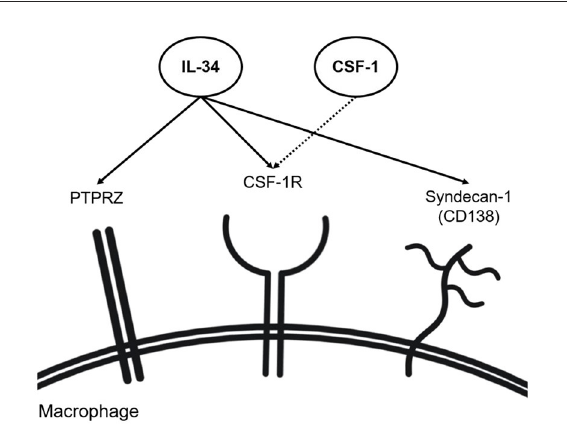
FIGURE1 IL-34 receptors (including co-receptors). IL-34 has shown the capability of binding to CSF-1R alongside CSF-1 on macrophages. Independent of CSF-1, IL-34 has shown binding to syndecan-1 and PTPRZ found on the surface of